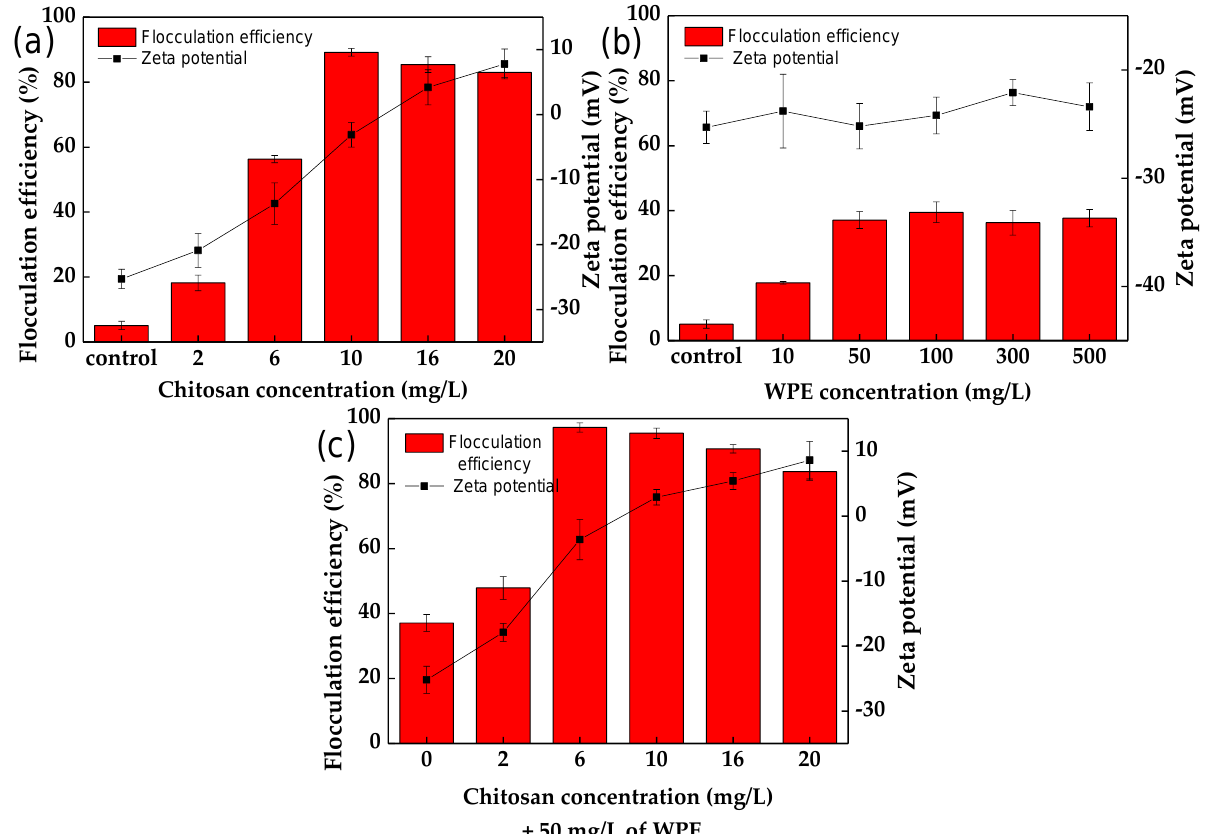
Figure 1. The effect of chitosan, WPE, and chitosan + WPE concentrations on the flocculation efficiency of C. vulgaris and the zeta potential of the flocs at pH 7: ( a ) chitosan; ( b ) WPE; ( c ) chitosan + WPE. The error bars represent the standard deviation of the mean ( n = 3).